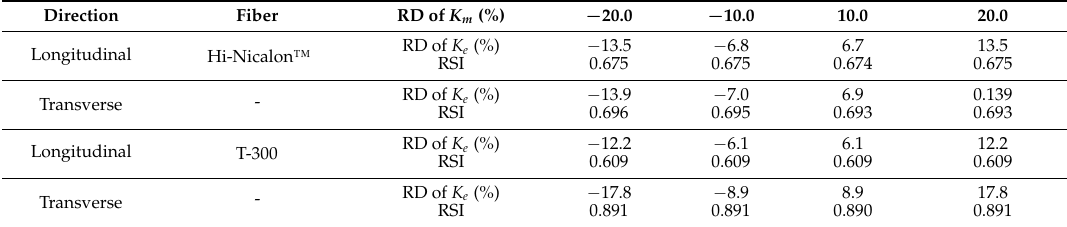
Table 9. Sensitivity analysis of thermal conductivity of matrix for 1D composites.